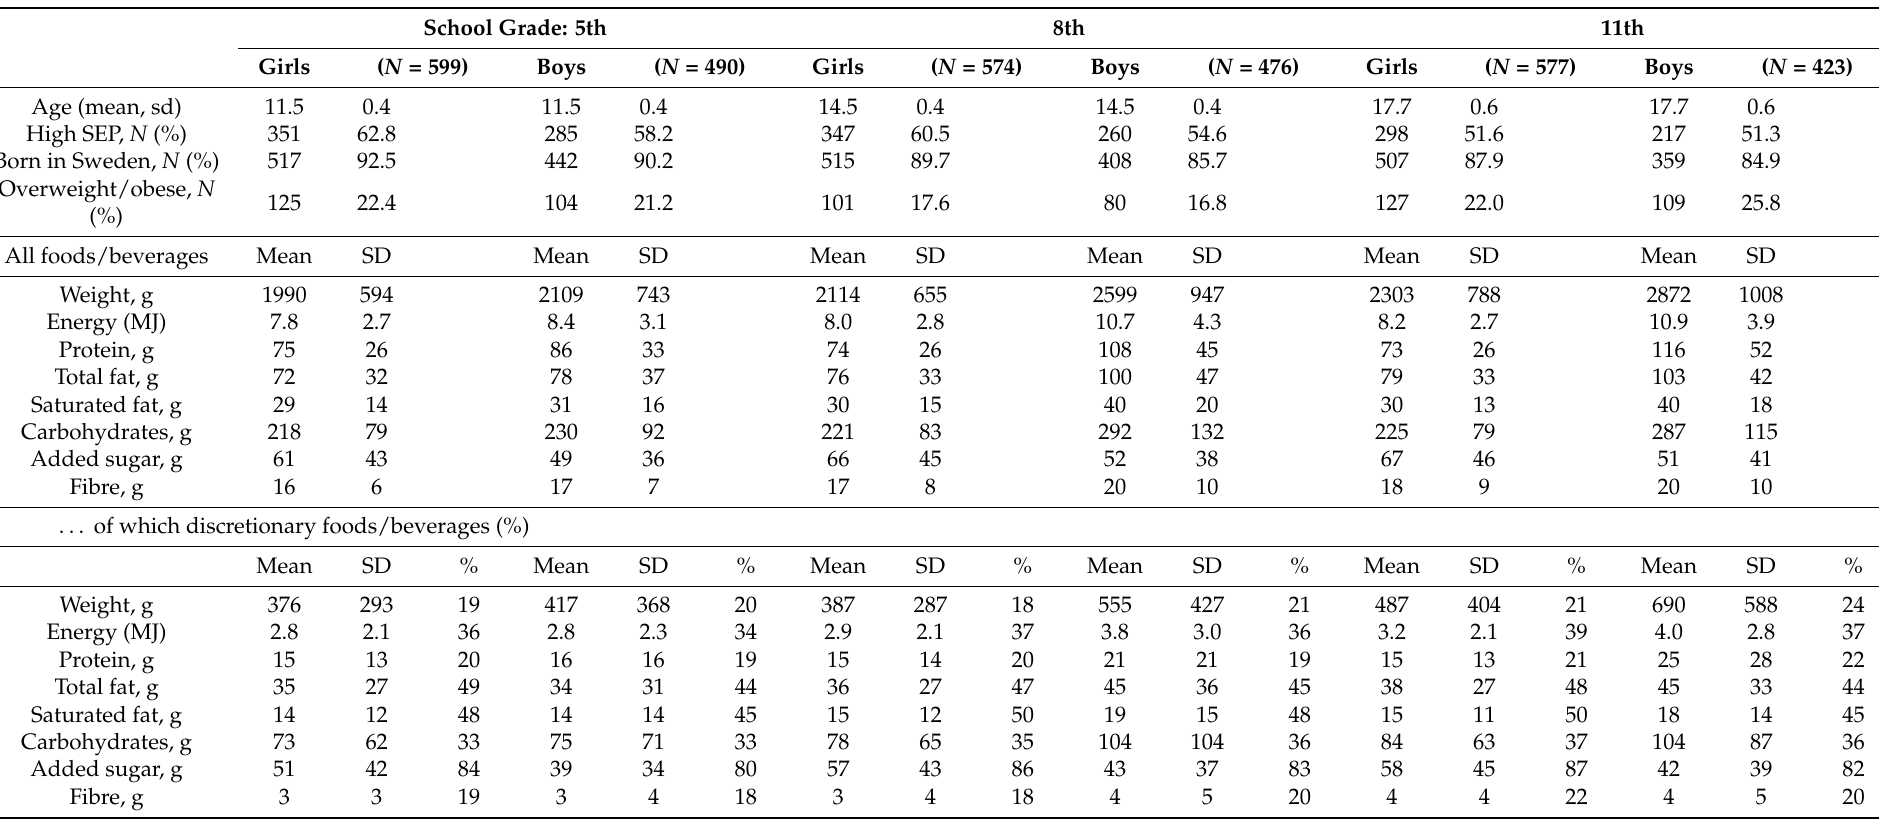
Table 1. Characteristics of participants and mean intakes of total energy and macronutrients from all foods/beverages and from discretionary